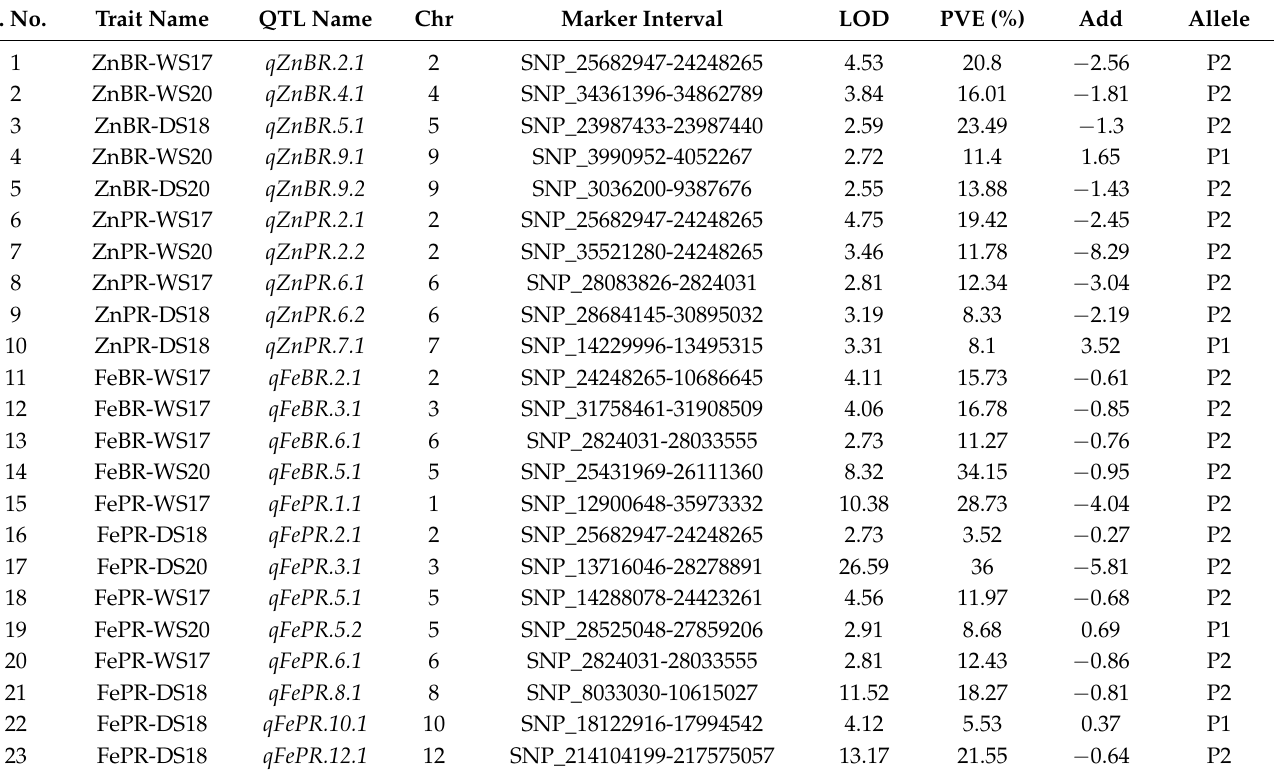
Table 5. Summary of major and minor QTLs for mineral traits (zinc (Zn) and iron (Fe)). S.